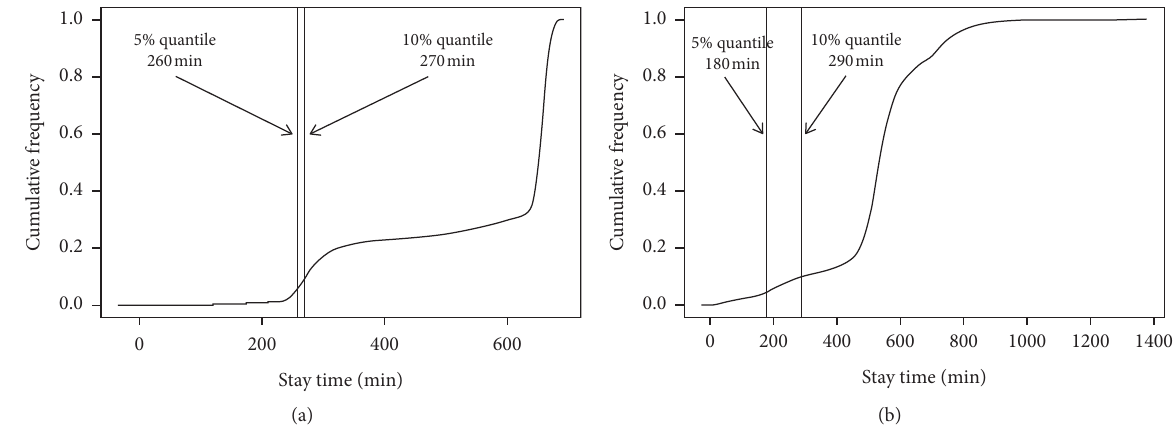
Figure 4: Cumulative frequency of home (a) and work duration (b) on weekday.